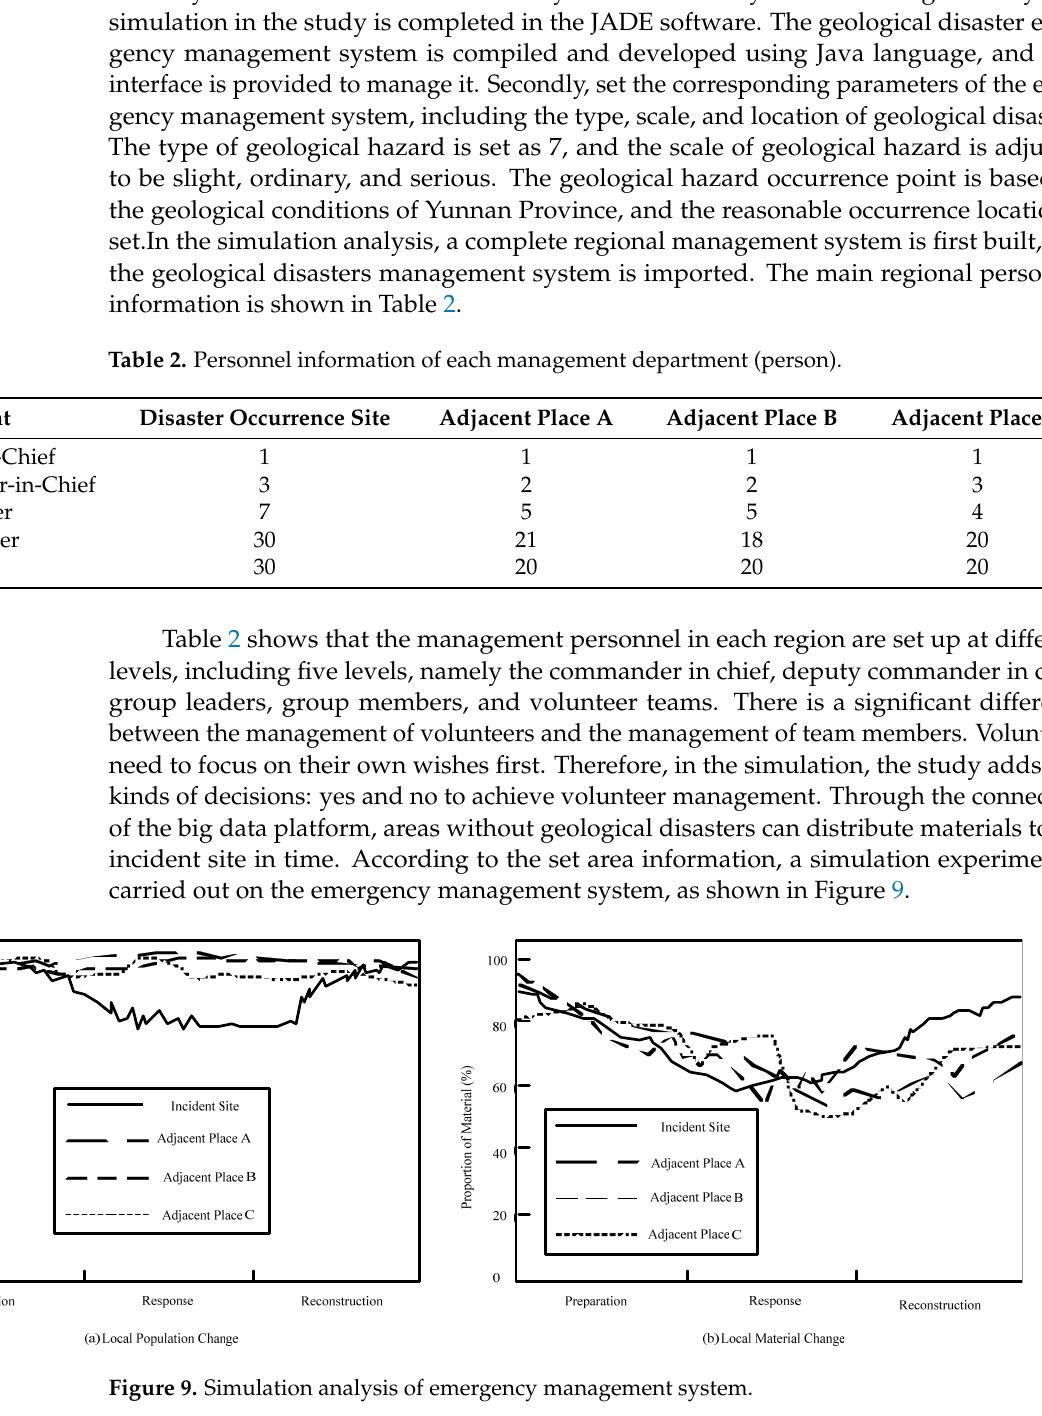
原始 应急管理体系 增益差 Figure 10. Practical application analysis of emergency management system.